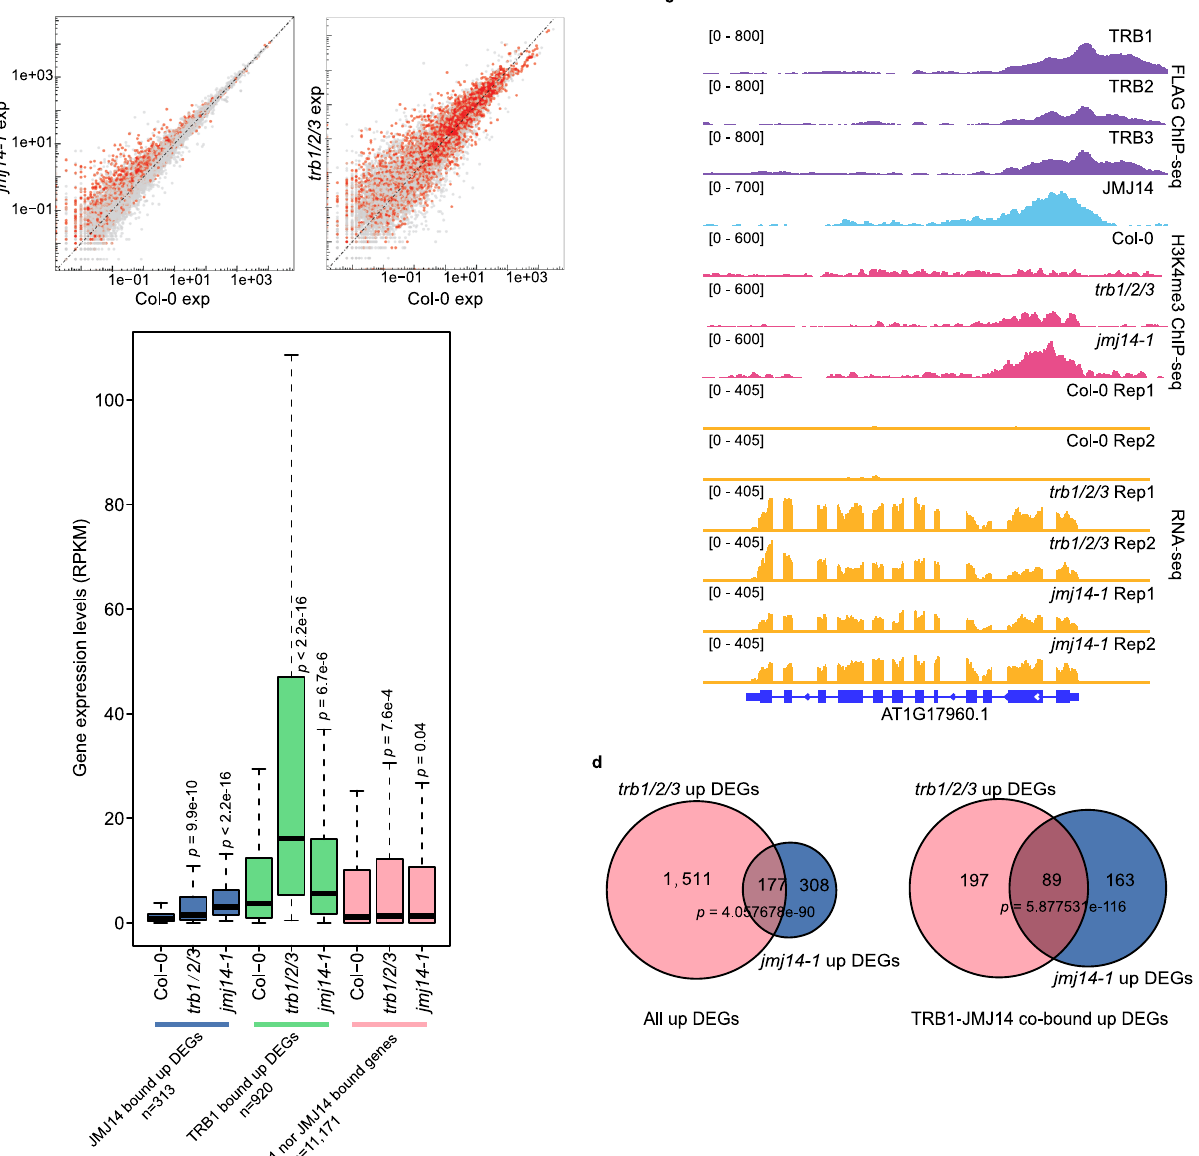
quartile, respectively. The whiskers represent the minimum and maximum values ofthedataset.The p valueisestimatedbytwo-sided t -test. c Screenshotsdescribing the FLAGChIP-seqsignals ofFLAG-TRB1, FLAG-TRB2,FLAG-TRB3, and FLAG-JMJ14, H3K4me3 ChIP-seq signals of Col-0, trb1/2/3 , and jmj14-1 mutants, as well as the RNA-seq signals of Col-0, trb1/2/3 , and jmj14-1 mutants. d Venn diagrams showing the overlap of all the up-regulated DEGs (left panel) or JMJ14-TRB1 co-bound up- regulated DEGs (right panel) between the trb1/2/3 triple mutant and the jmj14-1 mutant. The p value is estimated by one-sided hypergeometric